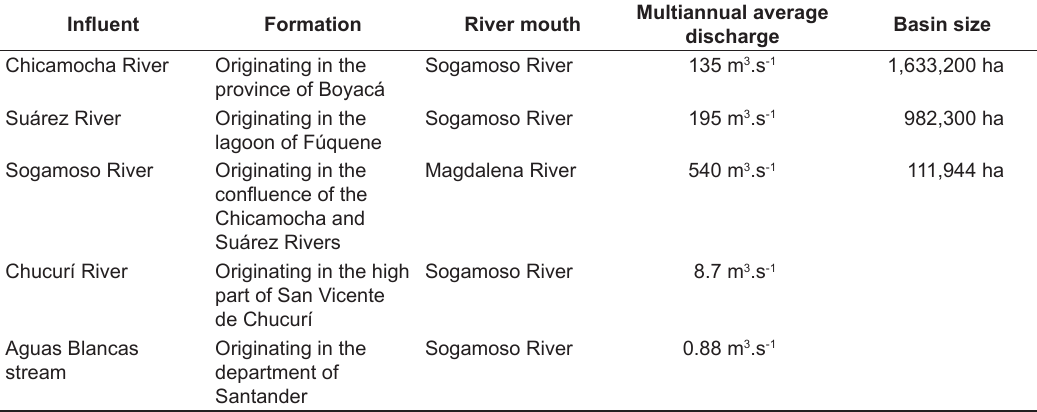
Table 2. Hidrosogamoso major tributaries main characteristics: Formation, River mouth, Multiannual average discharge (Discharge) and Basin size